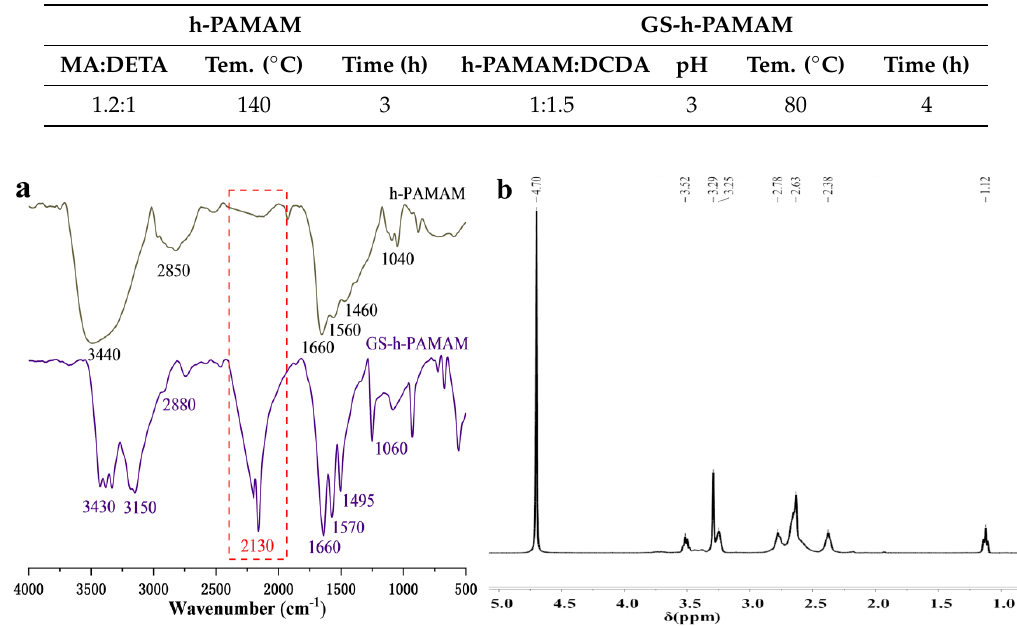
Figure 2. ( a ) FT-IR of h-PAMAM and GS-h-PAMAM; ( b ) 1 H NMR of h-PAMAM.